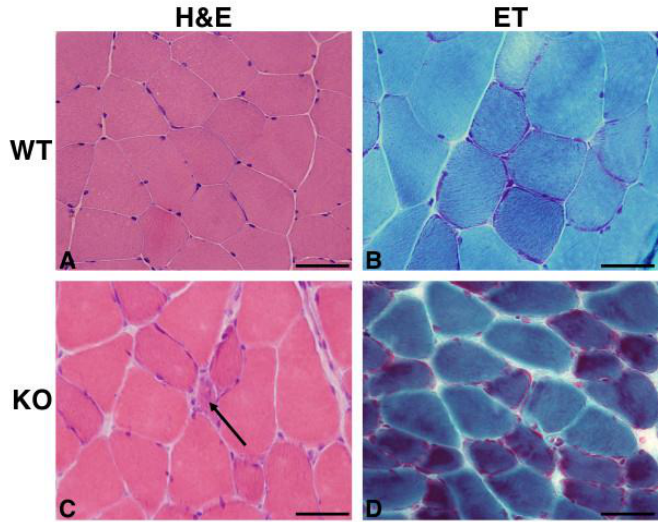
Figure 2. Morphological analysis of Hipk2 -KO skeletal muscle. Representative H&E and ET staining of sections from skeletal muscle of 18-month-old WT ( A , B ) and Hipk2 -KO ( C , D ) mice. The arrow indicates an atrophic angular fiber ( C ). Original magnification, 40×. Scale bar = 20 μm.